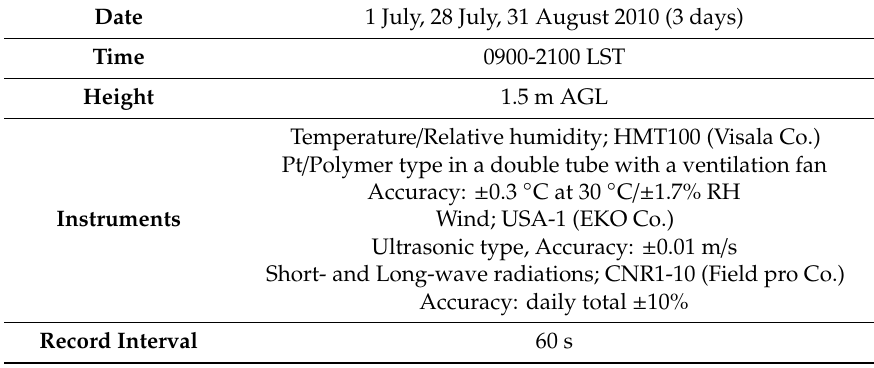
Table 2. Outline and instruments of stationary observation at P2.